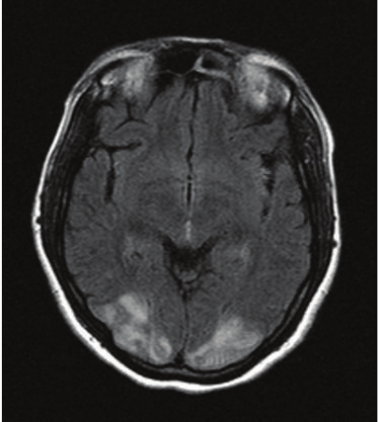
Figure 2: FLAIR axial images: hyperintense signal involving the white matter typically in occipital regions.